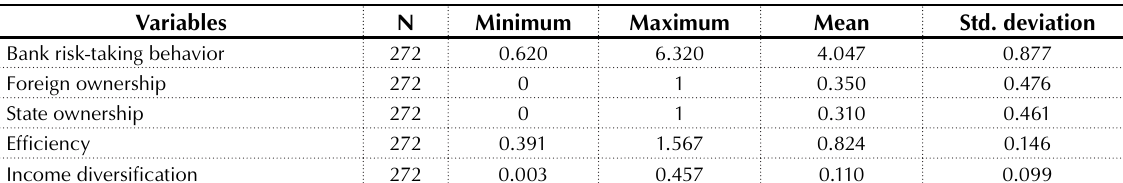
Table 1. Descriptive